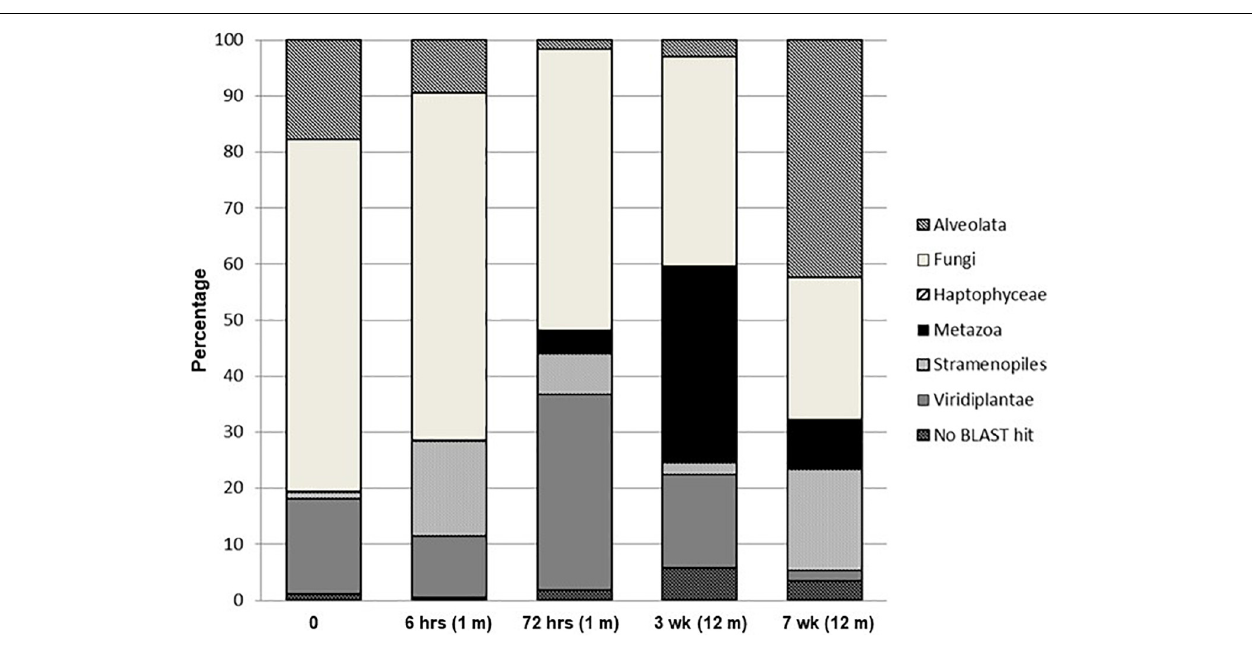
FIGURE 4 | Percentage distribution of eukaryotic phylogenetic groups from pyrosequenced 18S rRNA